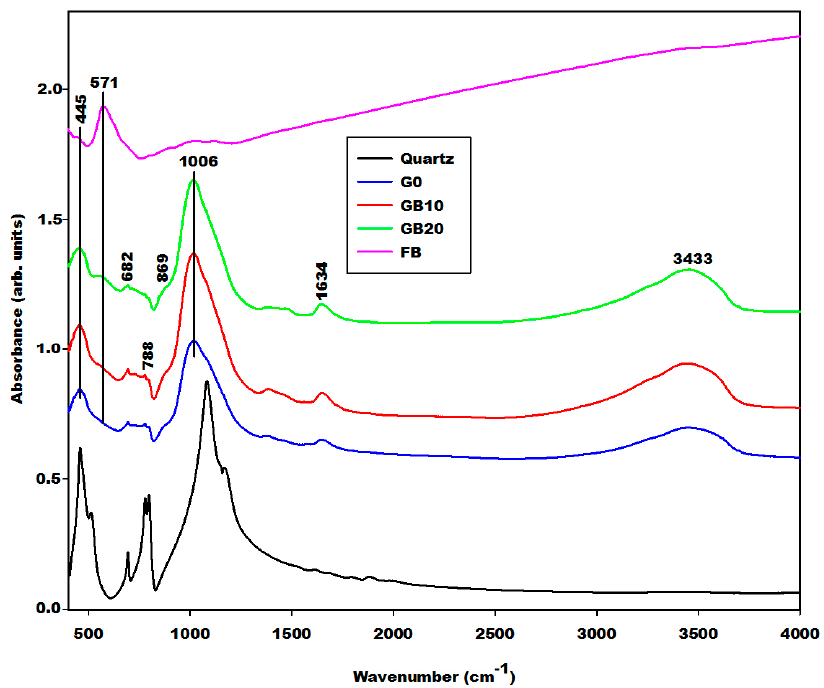
Figure 9. Infrared spectra of geopolymer materials (G0, GB10, GB20, quartz and FB: